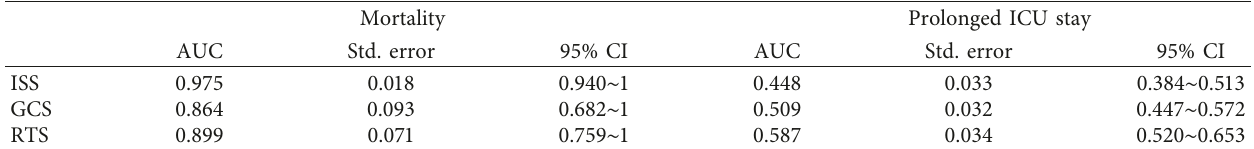
Table 4: AUC value of trauma score to mortality and prolonged ICU